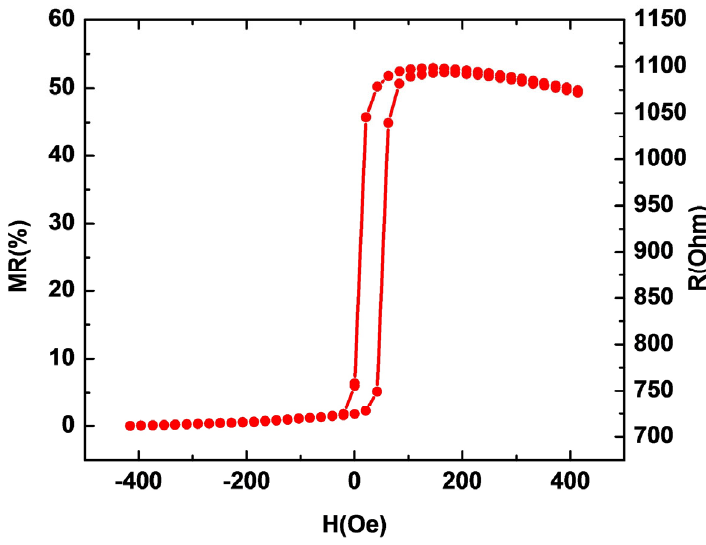
Figure 6. Sensor transfer curve.